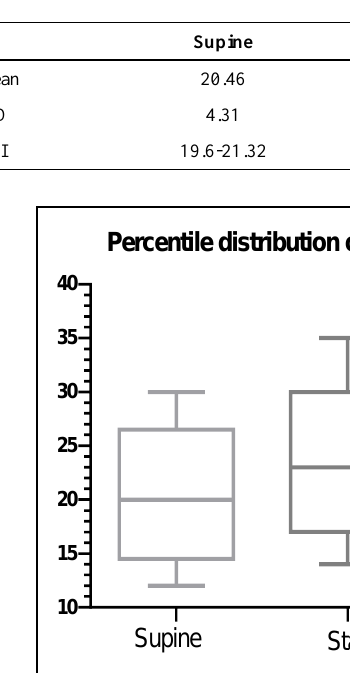
Table1. Comparison of mean and SD of Q angle measurement in supine and standing position